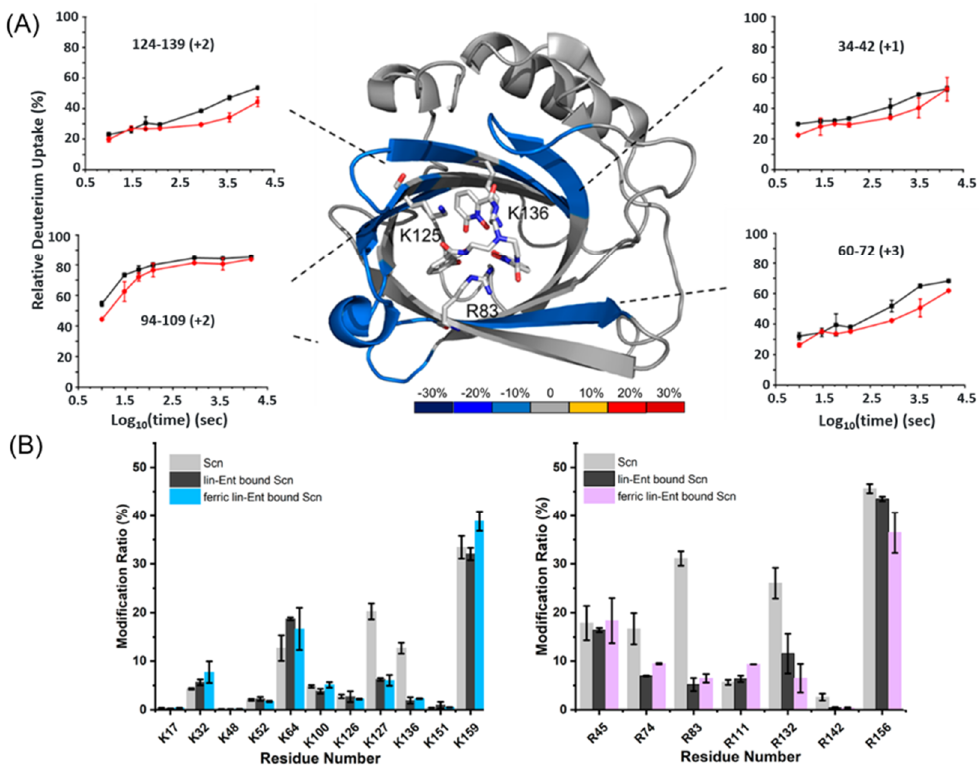
Figure 3. HDX and targeted amino-acid footprinting result of siderocalin binding to ferric and aferric Ent–Scn. ( A ) Representative HDX kinetic plots: red represents unbound Scn state; black represents Ent-bound state. Average percentage differences between Ent-bound and -unbound states are mapped on the Scn structure (PDB: 3HWG). The cold color indicates protection upon Ent binding. The protection level is shown in the color scale bar. ( B ) ETAT and MG footprinting: residue level modification comparison between Scn, aferric Ent-Scn and ferric Ent–Scn. Reproduced with permission from Ref. [39]. Copyright 2020 American Chemical Society.